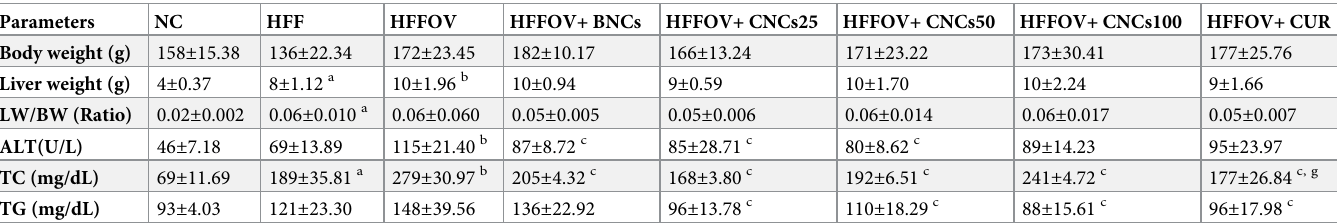
Table 3. Parameters relating to NAFLD/NASH disease of hamsters in the experimental groups at the end of three months.